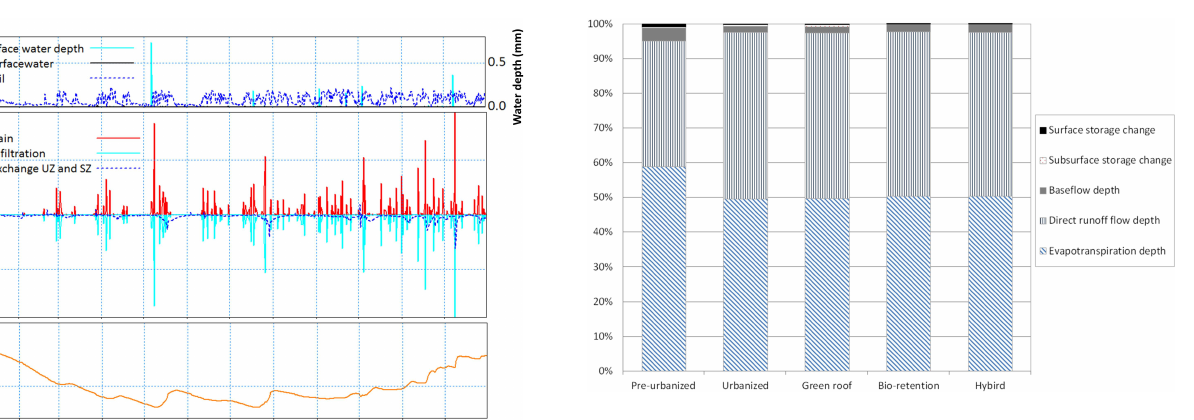
Fig. 5. Water balance aggregated over one year for different scenar-